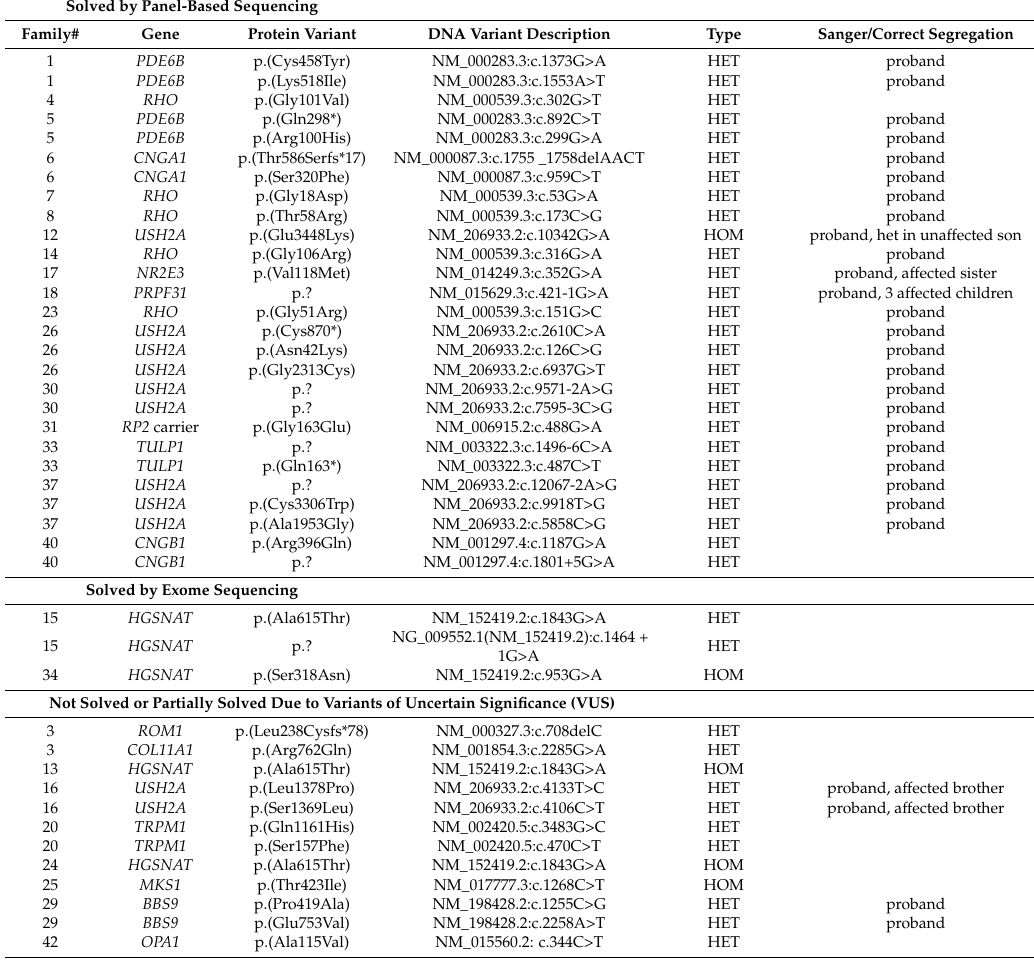
Table 2. Genetic causes of disease in the pericentral RP cohort, including probands whose cause of disease was solved by panel-based sequencing (top) or whole exome sequencing (WES) (middle). Unsolved probands with VUS are shown below. Also, see Supplemental Table S1 for a more fully annotated version including genomic coordinates, pathogenicity predictions, and